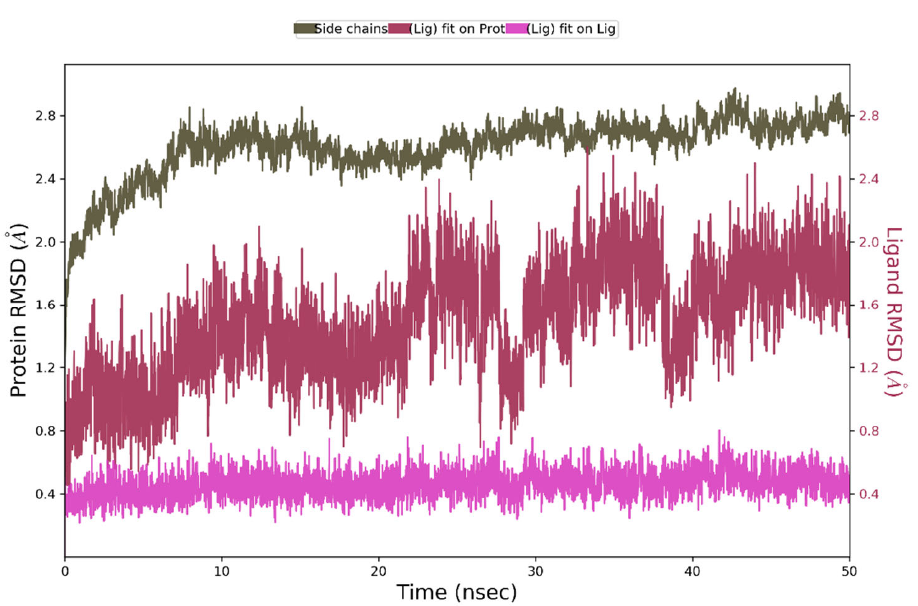
Figure 9. The above plot shows the RMSD evolution of a protein backbone (green) and Compound 4 (aligned to its reference conformation – pink, aligned on the protein backbone of the reference position ‐ magenta) calculated for all frames in the simulation.